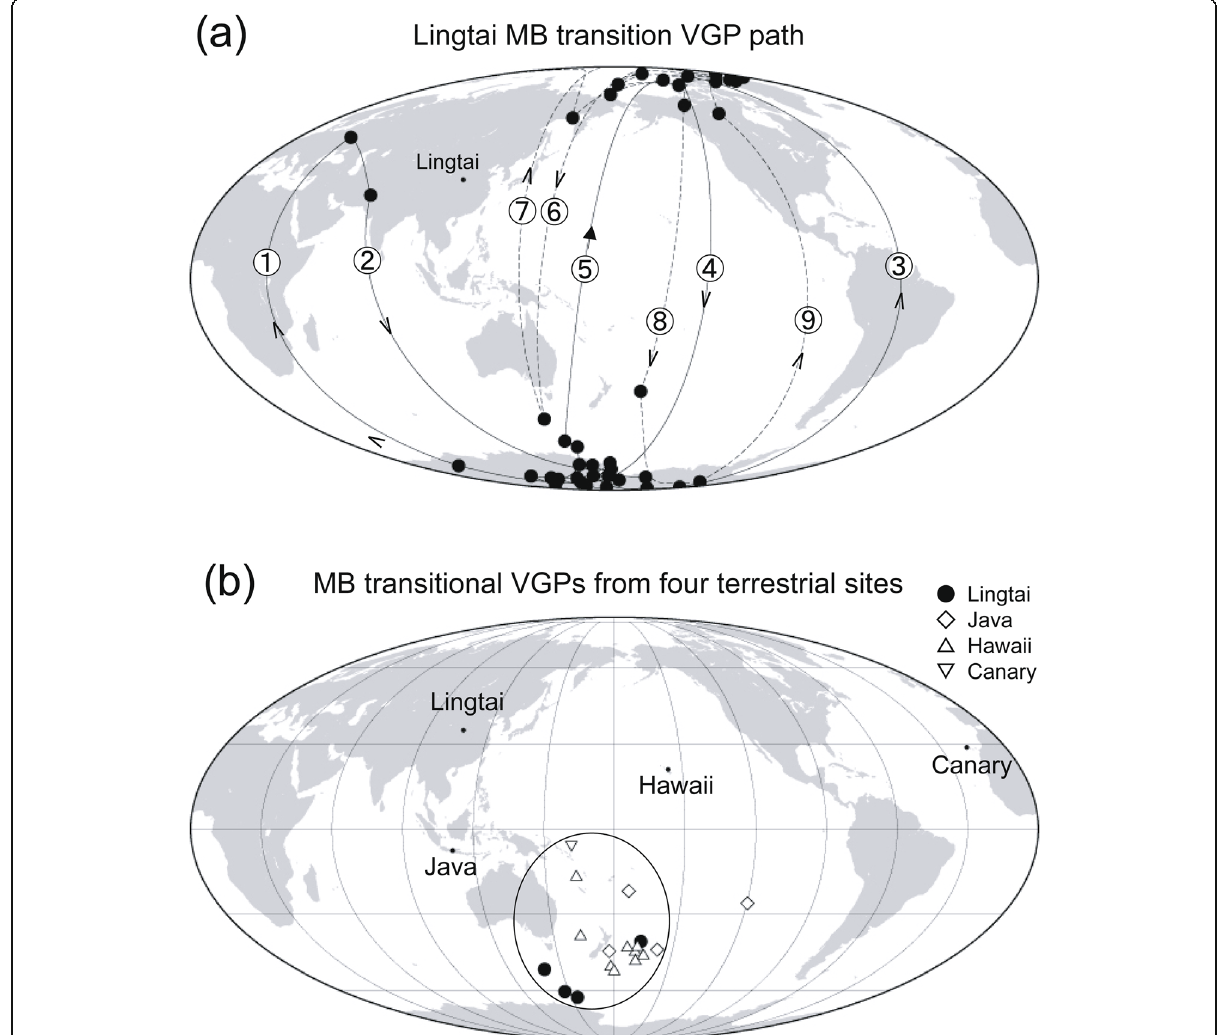
Fig. 7 The Matuyama – Brunhes (MB) transition VGPs. a The VGP pass during the MB polarity flip zone. The polarity changes are numbered 1 – 9. The pass after no. 5 polarity change is shown by broken lines. b The MB transitional VGPs clustered in the southwest Pacific from the four terrestrial sites of Lingtai (this study), Java (Hyodo et al. 2011), and the Hawaii and Canary Islands (Coe et al. 2004; Singer et al.